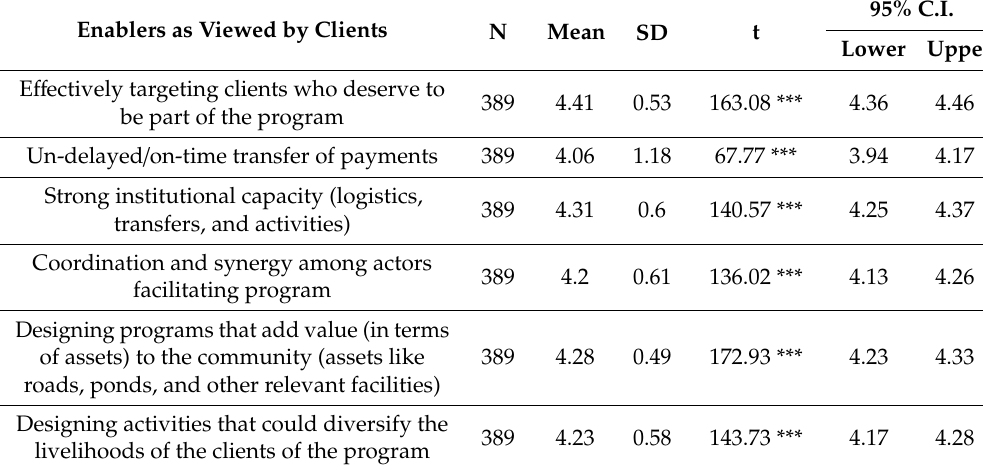
Table 1. Public Works Clients’ View of Enablers of E ff ective Service